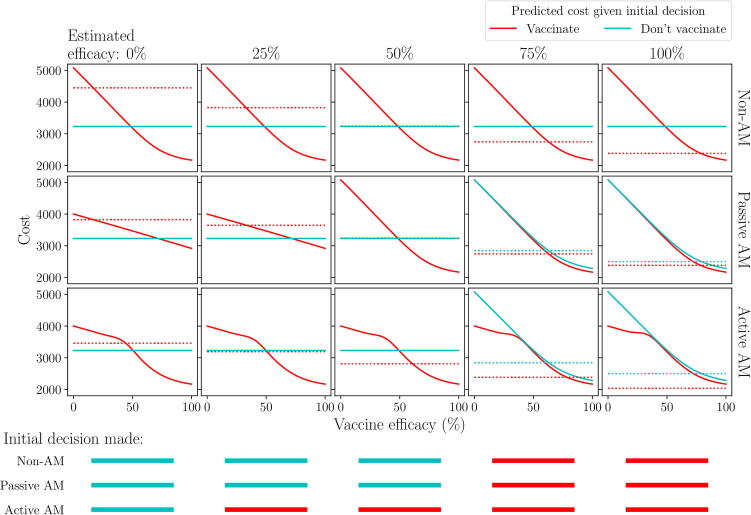
Example effect of prior information on the expected cost of the outbreak given an initial decision to vaccinate or not. We set x0+y0=4 and vary the estimate of vaccine efficacy (the mode of the distribution x0x0+y0) across columns. Rows 1–3: predicted outbreak cost over vaccine efficacy, given an initial decision to vaccinate (red) or not (blue), for different prior estimates of efficacy, as viewed under a non-AM, passive AM or active AM approach respectively. Bottom row: initial decision made under each approach, for different prior estimates of efficacy: vaccinate (red) or don’t (blue). Epidemiological and vaccination parameters are set to those in Table A.2: Scenario 1.